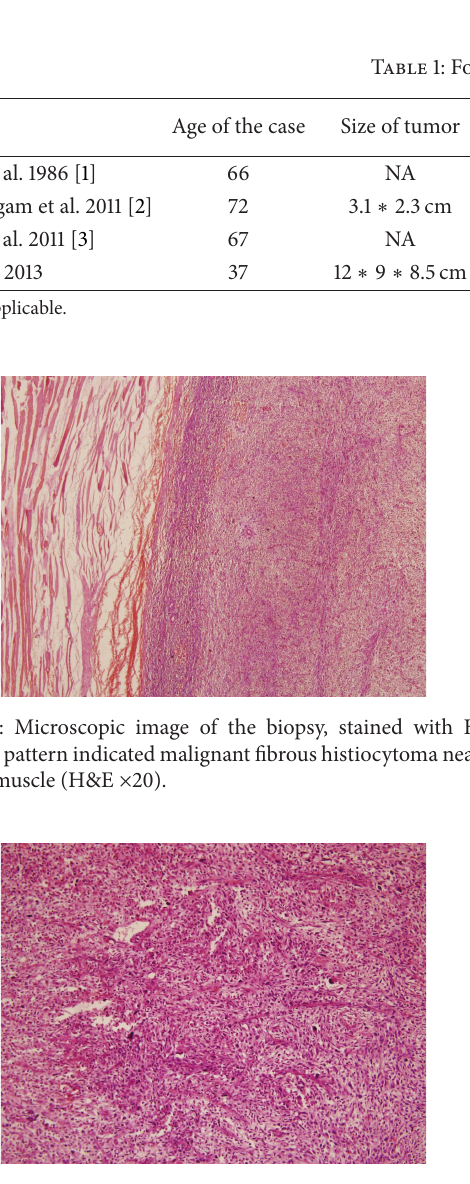
Figure 2: Microscopic image of the biopsy, stained with H&E; epithelioid spindle cells among giant cells in it (H&E × 40).